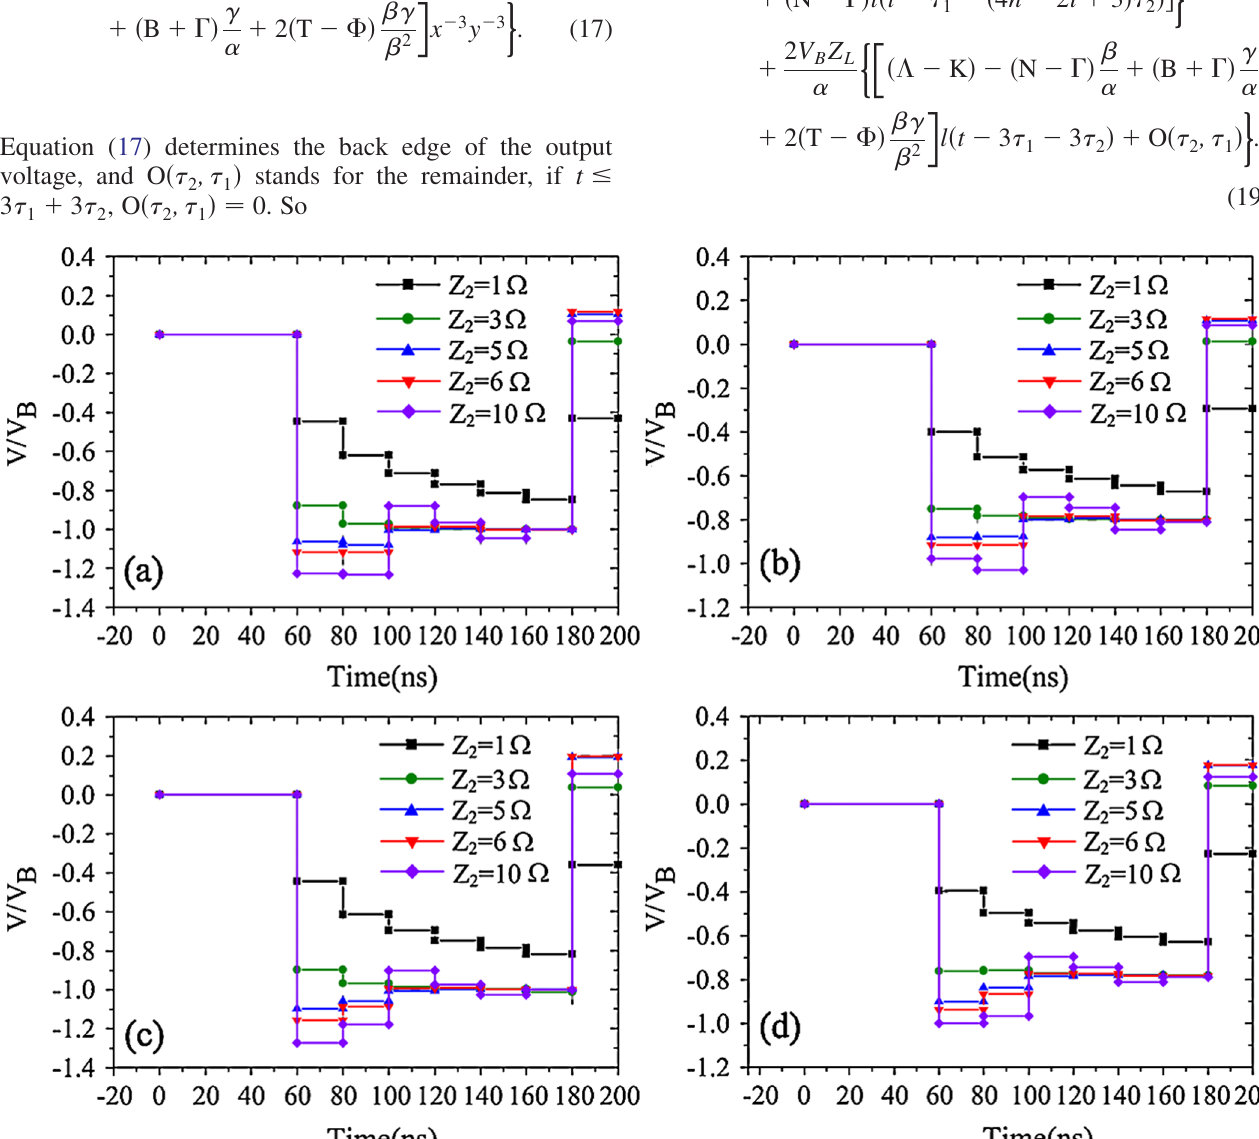
FIG. 3. (Color) The main pulse of the output voltage at different conditions, in all cases, (cid:1) 1 ¼ 50 ns , (cid:1) 2 ¼ 10 ns : (a) Z 1 ¼ Z 3 ¼ 6 (cid:6) , ¼ 12 (cid:6) ; (b) Z Z L